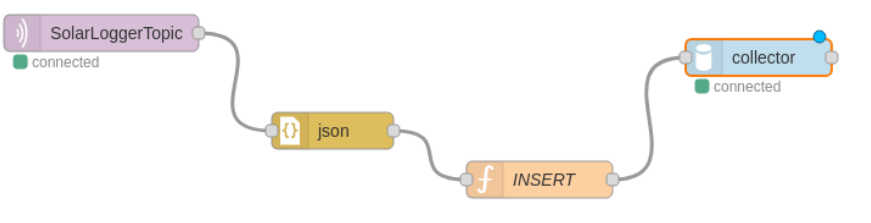
Figure 2. NodeRED